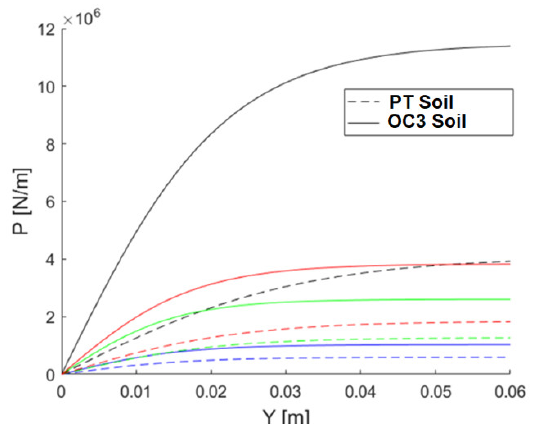
Figure 7. Di ff erent p-y curves at di ff erent depths for the two studied soils—bigger depths (Y) are Figure 7. Different p-y curves at different depths for the two studied soils—bigger depths (Y) are related with bigger soil reactions (P). related with bigger soil reactions (P).